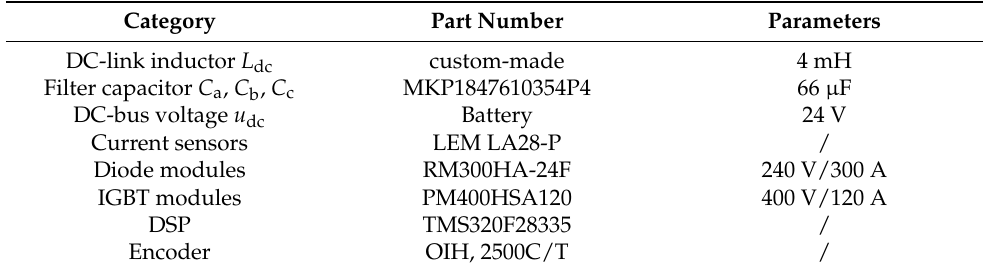
Figure 20. Prototype for CSI − fed IM drive system with bidirectional DC chopper. Table 5. Models and parameters of the experimental